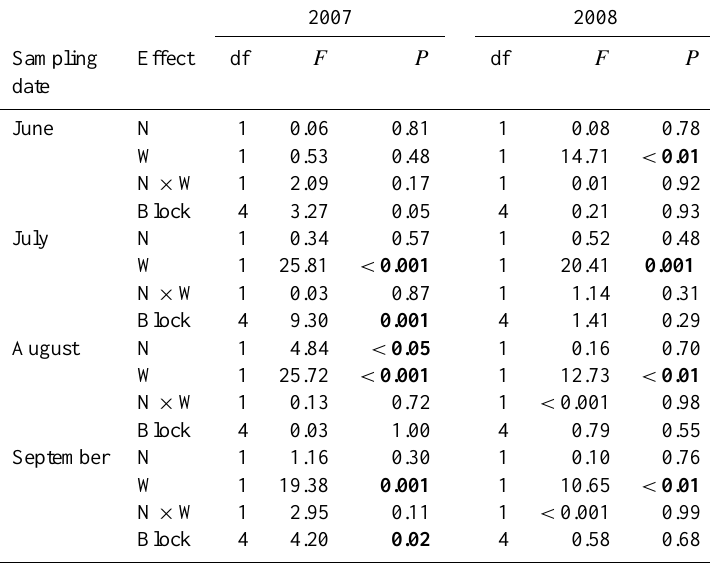
Table 3. Results from two-way ANOVA testing effects of nitrogen (N) and water addition (W) on live fine root biomass in 2007 and 2008. Significant effects ( P < 0 . 05) are indicated in